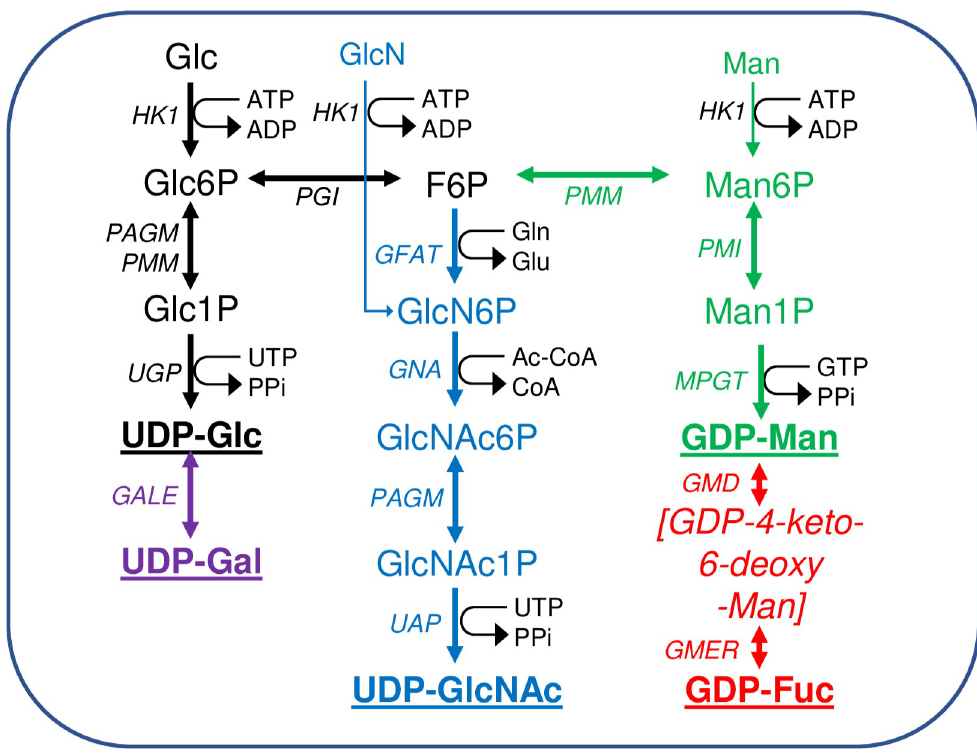
Fig 1. Scheme of nucleotide sugar biosynthesis in T . brucei . Nucleotide sugar biosynthesis in T . brucei according to [34], showing the 14 biotransformations and 13 enzymes involved. No dedicated phospho-glucose mutase (PGM) gene exists in T. brucei and the interconversion of Glc6P and Glc1P is performed by PAGM and/or PMM [42]. The enzyme abbreviations ( in italics ) appear in the Introduction. The terminal nucleotide sugars used for glycosylation reactions are in bold and underlined. Information on enzyme essentiality, protein and antibody production, and sub-cellular localisation appear in (Table 1). The main source of all of the nucleotide sugars is Glc but both Man and GlcN can enter their respective pathways via hexokinase